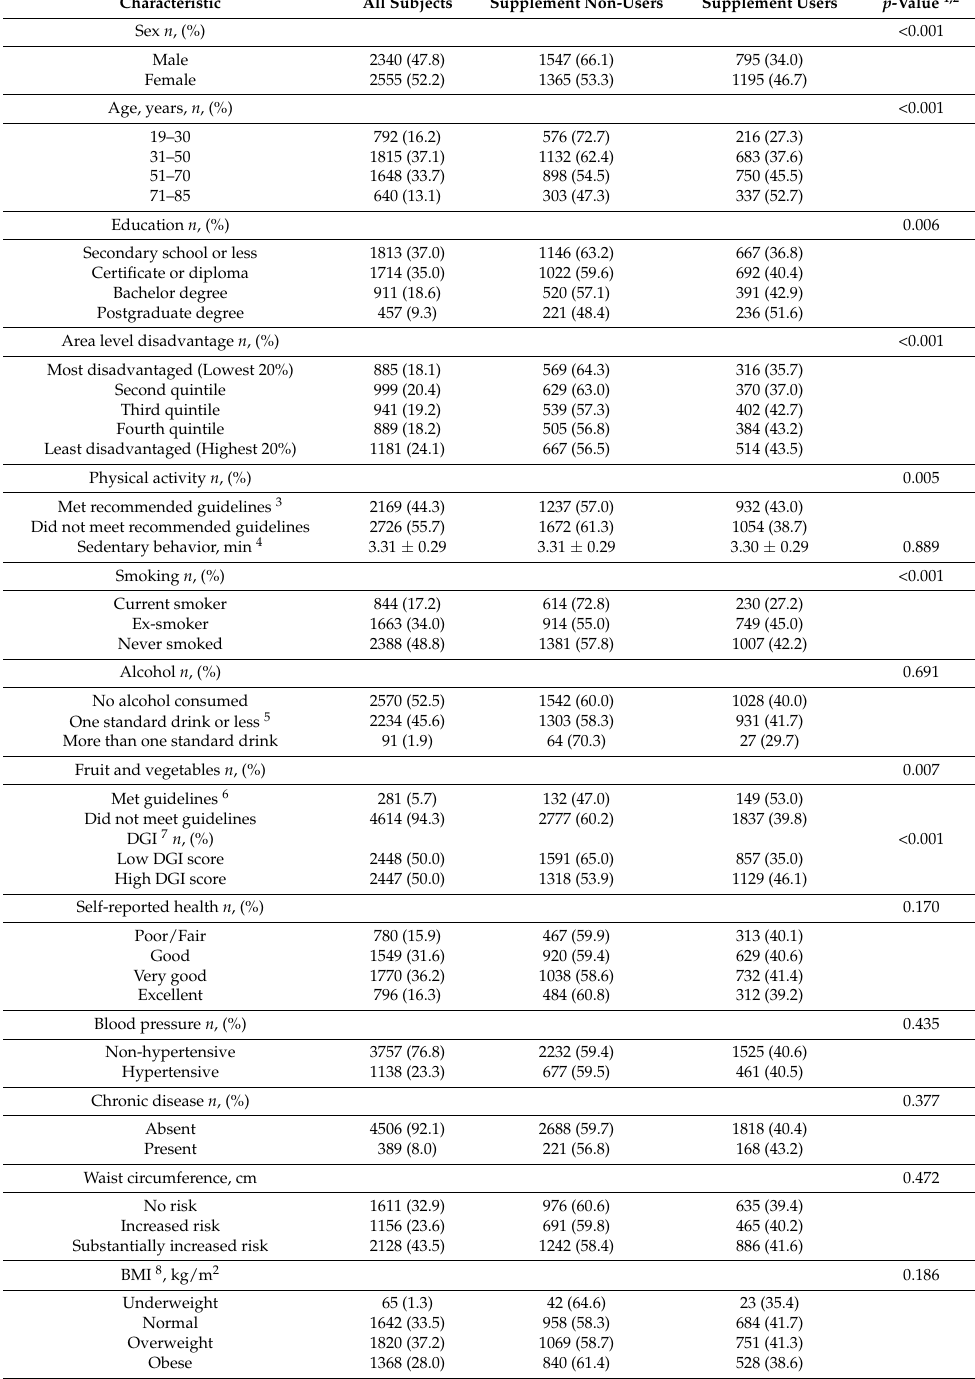
Table 1. Demographic, lifestyle and health status characteristics of Australian adults in the Australian Health Survey ( n =